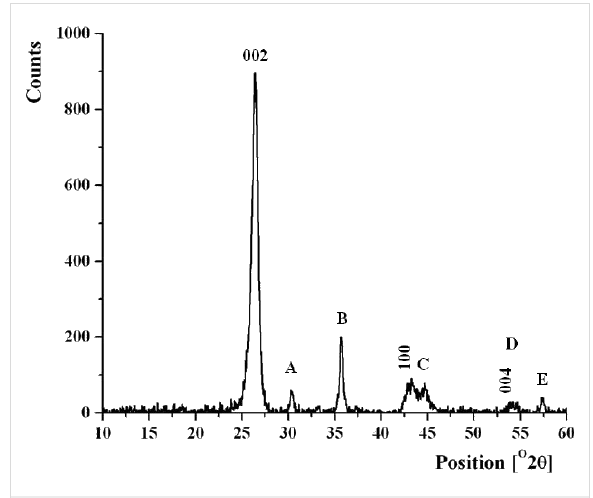
Figure 11: XRD pattern of N-CNTs ( Synthesis VIII ). The numbers are the hkl indices of the highest intensity peaks of graphite that coincide with the peaks from N-CNTs. The other peaks possibly refer to iron- based